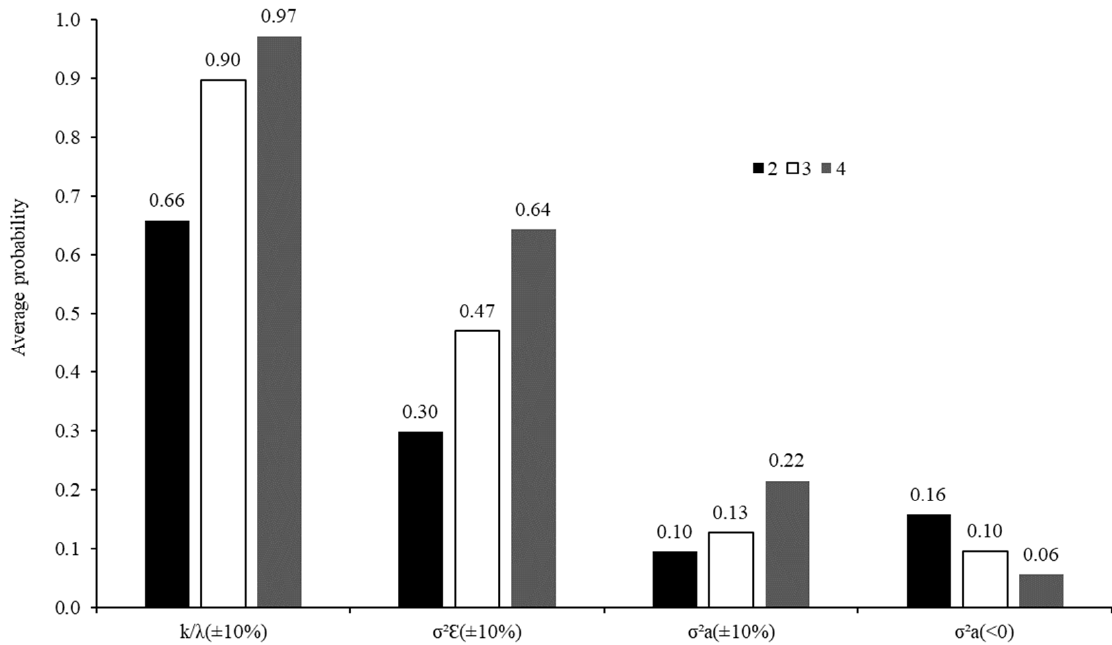
Figure 6. Average probabilities for obtaining estimates of degradation rate [k/ λ ( ± 10%)], error variance [ σ 2 E ( ± 10%)], and variance among animals on degradation rate [ σ 2 a ( ± 10%)] lower or higher than 10% in relation to those obtained using five animals, and average probabilities for obtaining negative estimates of variance among animals on degradation rate according to the number of animals used in the in situ trial.